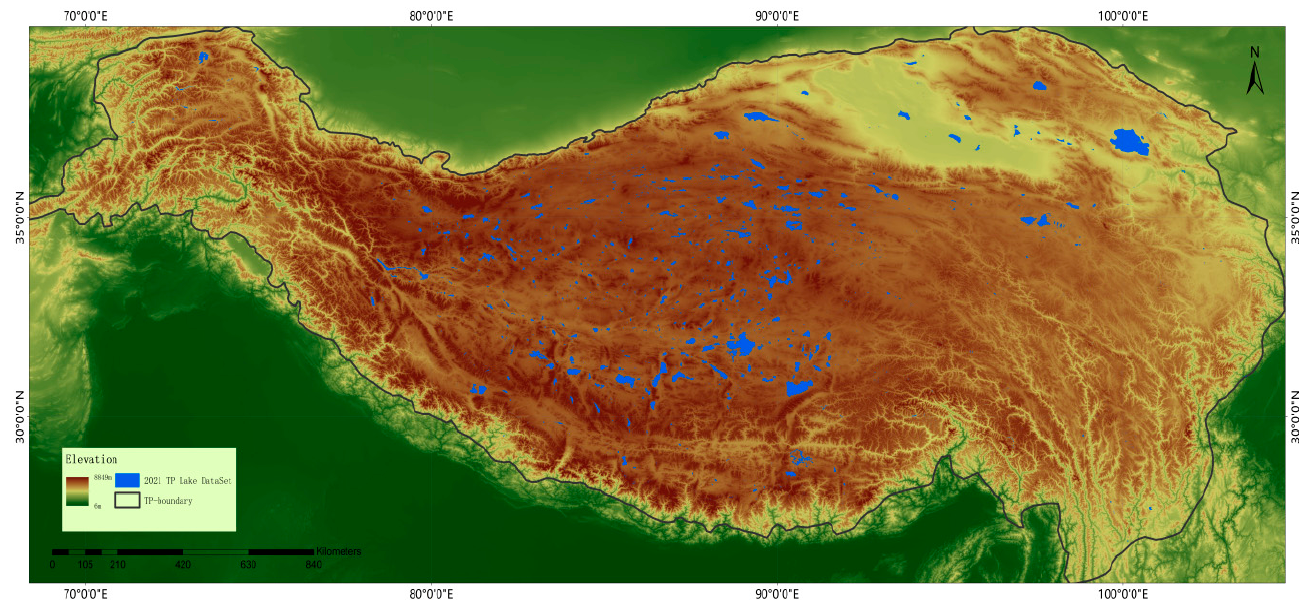
Figure 1. Schematic diagram of the study area. The base map is from the digital elevation data produced by The Shuttle Radar Topography Mission (SRTM). The TP Lake DataSet and TP boundary are vector datasets obtained by the National Tibetan Plateau Scientific Data Center.